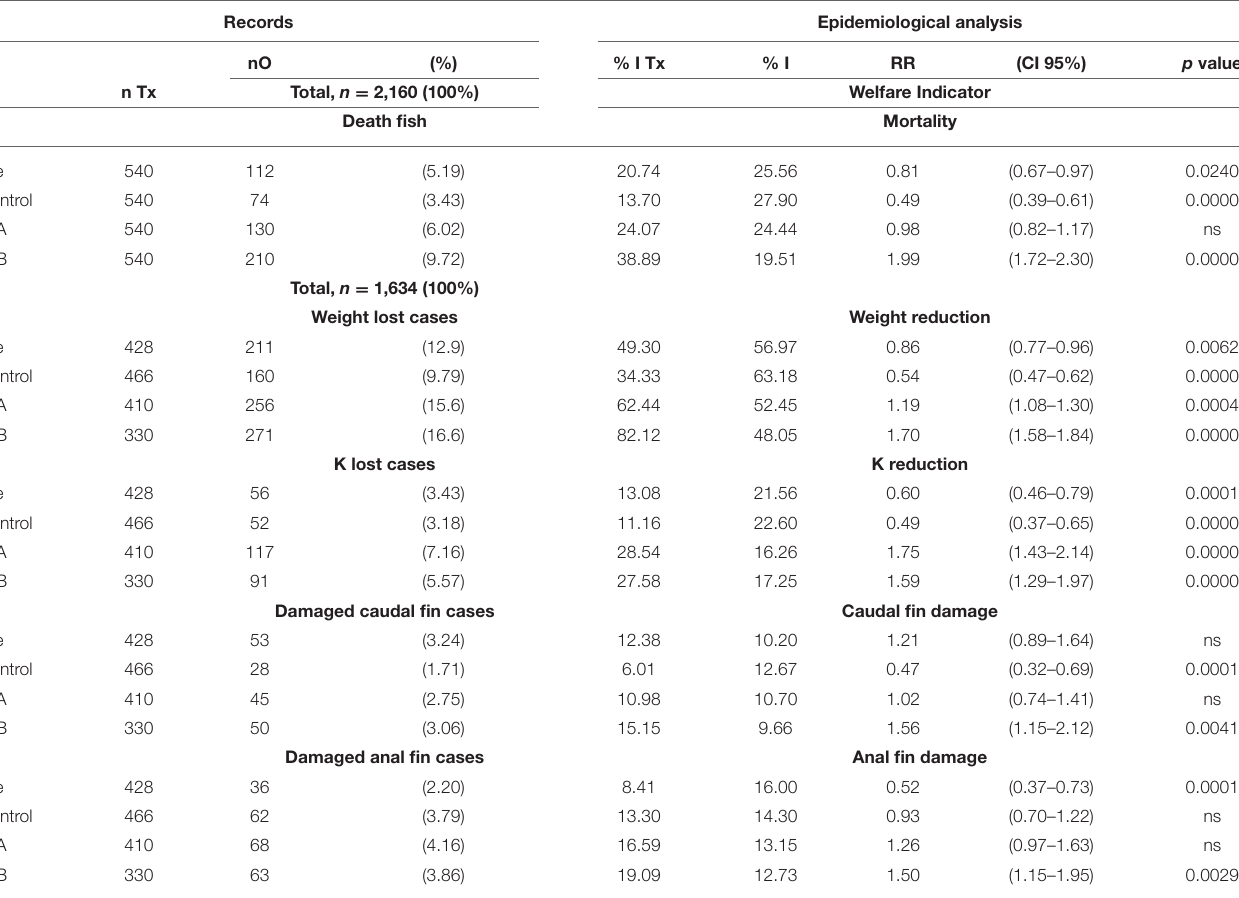
TABLE 4 | Contingency table, incidence of mortality, weight reduction, K reduction and caudal and anal fin damage of O. niloticus fingerlings according to the feeding